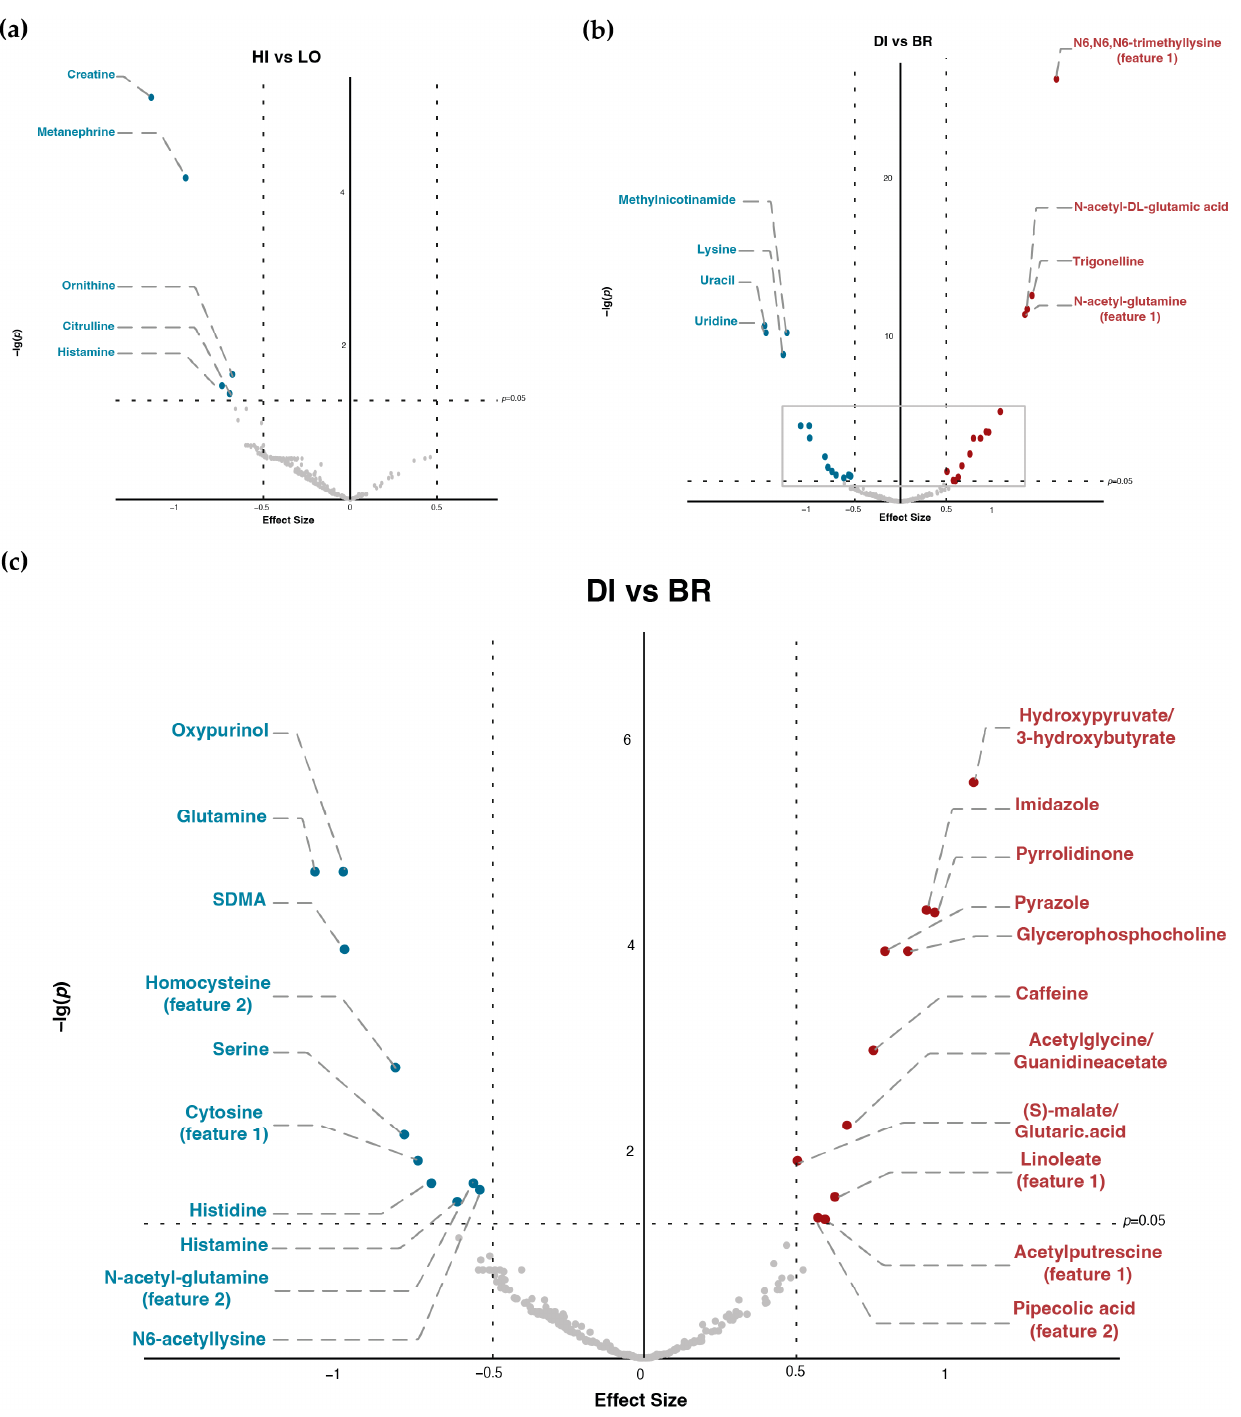
Figure 2. Alteration of metabolites AUC under different TM timing and GI content. ( a ) Volcano plot of high-GI versus low-GI TM (HI: high-GI; LO: low-GI; effect size: AUC (HI) –AUC (LO) ). ( b ) Volcano plot of dinner versus breakfast (DI: dinner; BR: breakfast; effect size: AUC (DI) –AUC (BR) ; figure area within the grey frame is zoomed in as ( c )). ( c ) Zoomed-in volcano plot of dinner versus breakfast (DI: dinner; BR: breakfast; effect size: AUC (DI) –AUC (BR) ).